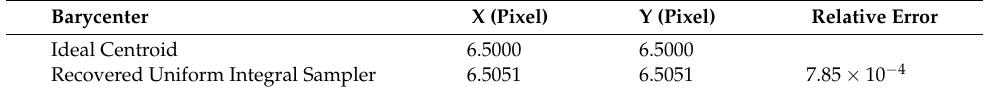
Table 2. Barycenter of the Image by the Recovered Uniform Integral Sampler.